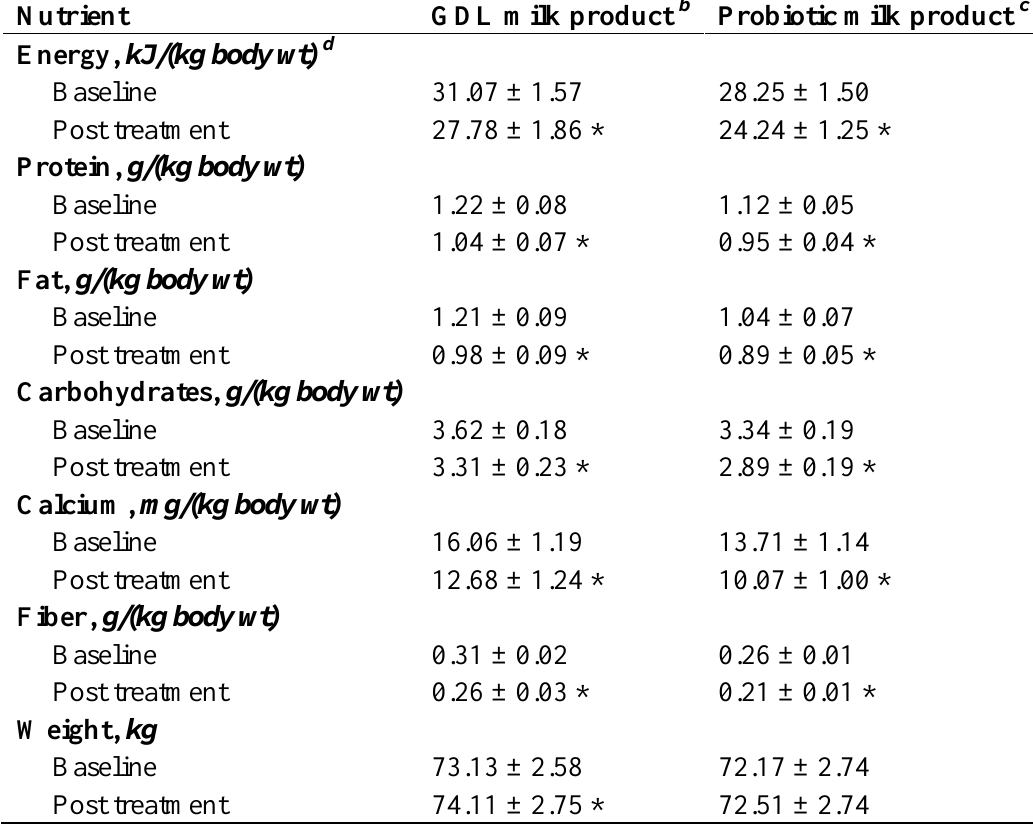
Table 1. Summary of 3-day energy intake record by IBS patients before sample collection a and IBS patients’ body weight measurements. Patient data from samples included in the 1 H-NMR